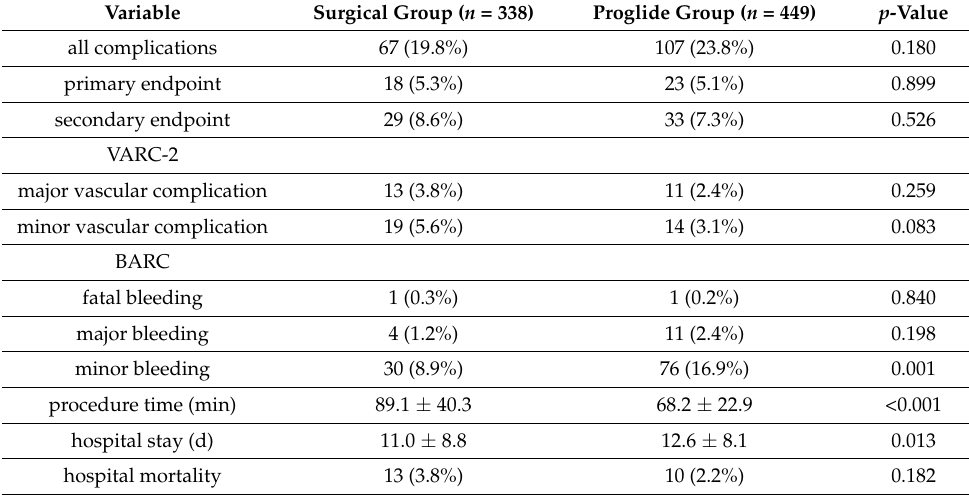
Table 3. Postoperative